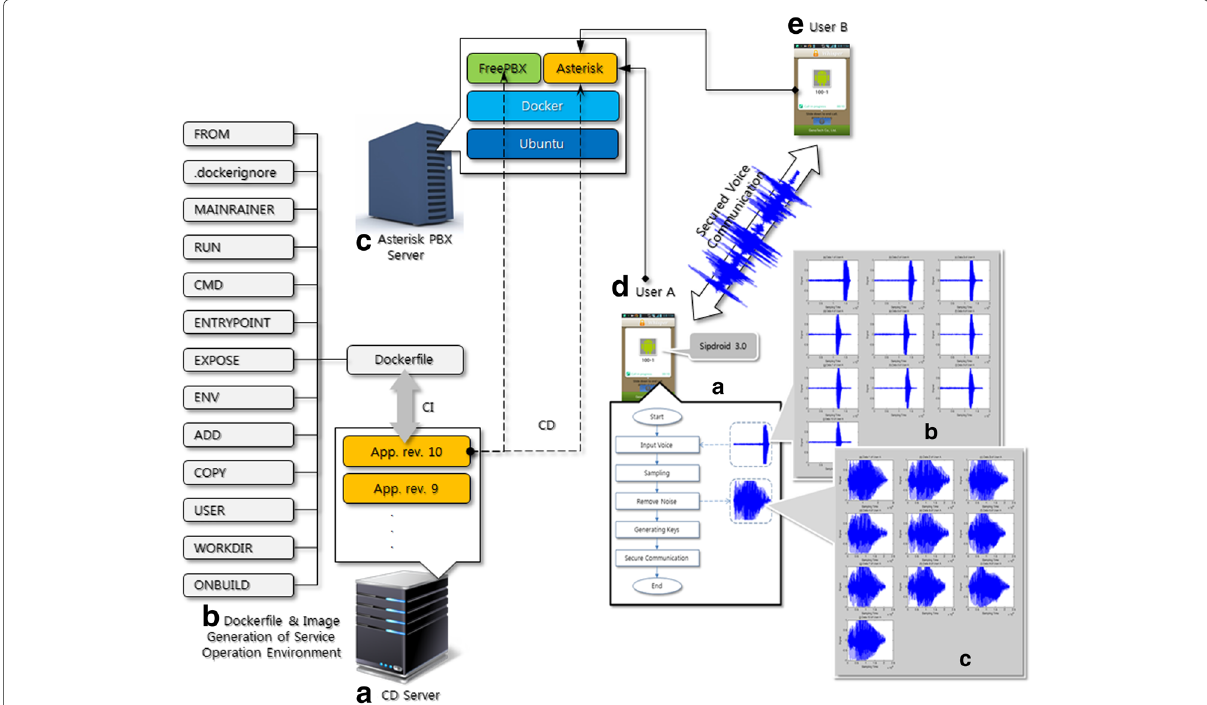
Fig. 6 Diagram of the immutable infrastructure for Docker-based secure mVoIP. a CD server. b Dockerfile and image generation of service operation environment. c Asterisk PBX server. d User A. e User